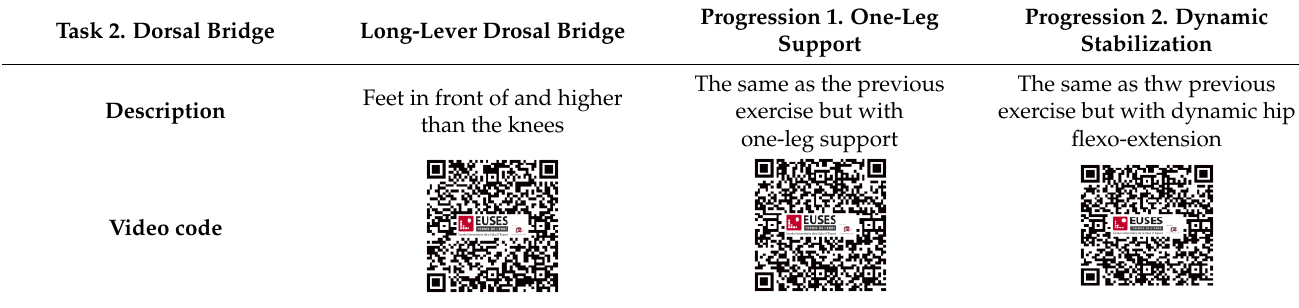
Table 7. Description and methodologic criteria of GCS group’s task 2 and its progressions. Task 2. Dorsal Bridge